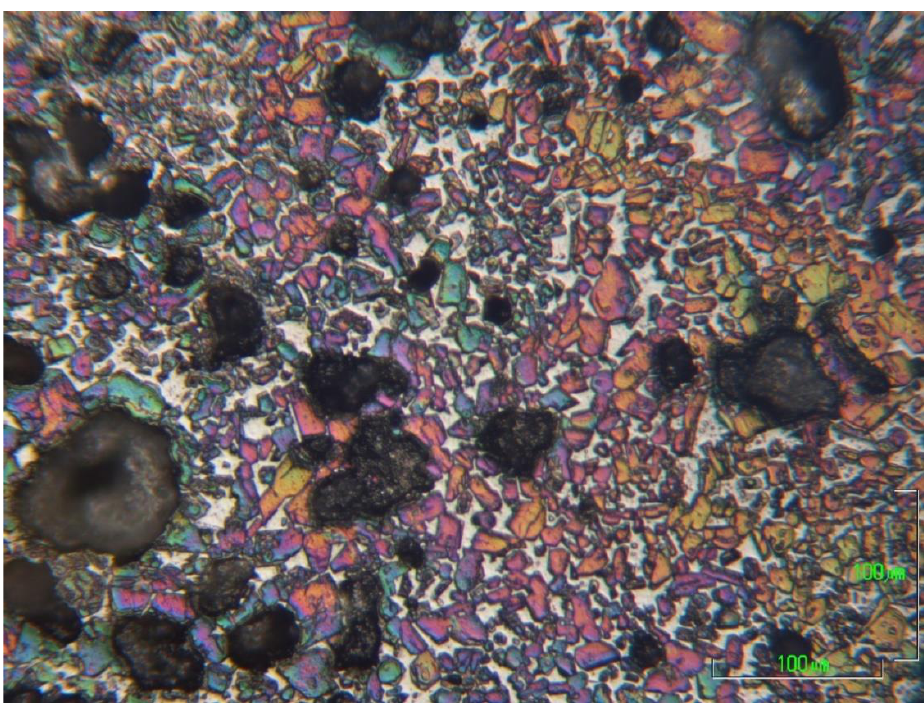
Figure 12. Image of optical microscopy of P 71A_1450 .